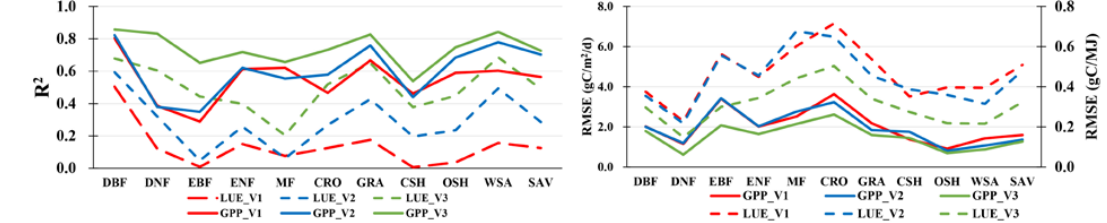
Figure 3. The accuracy of 3 approaches in each type of vegetation. V1: Parameterization approach without the CI; V2: Parameterization approach with the CI; V3: Cubist regression tree approach.